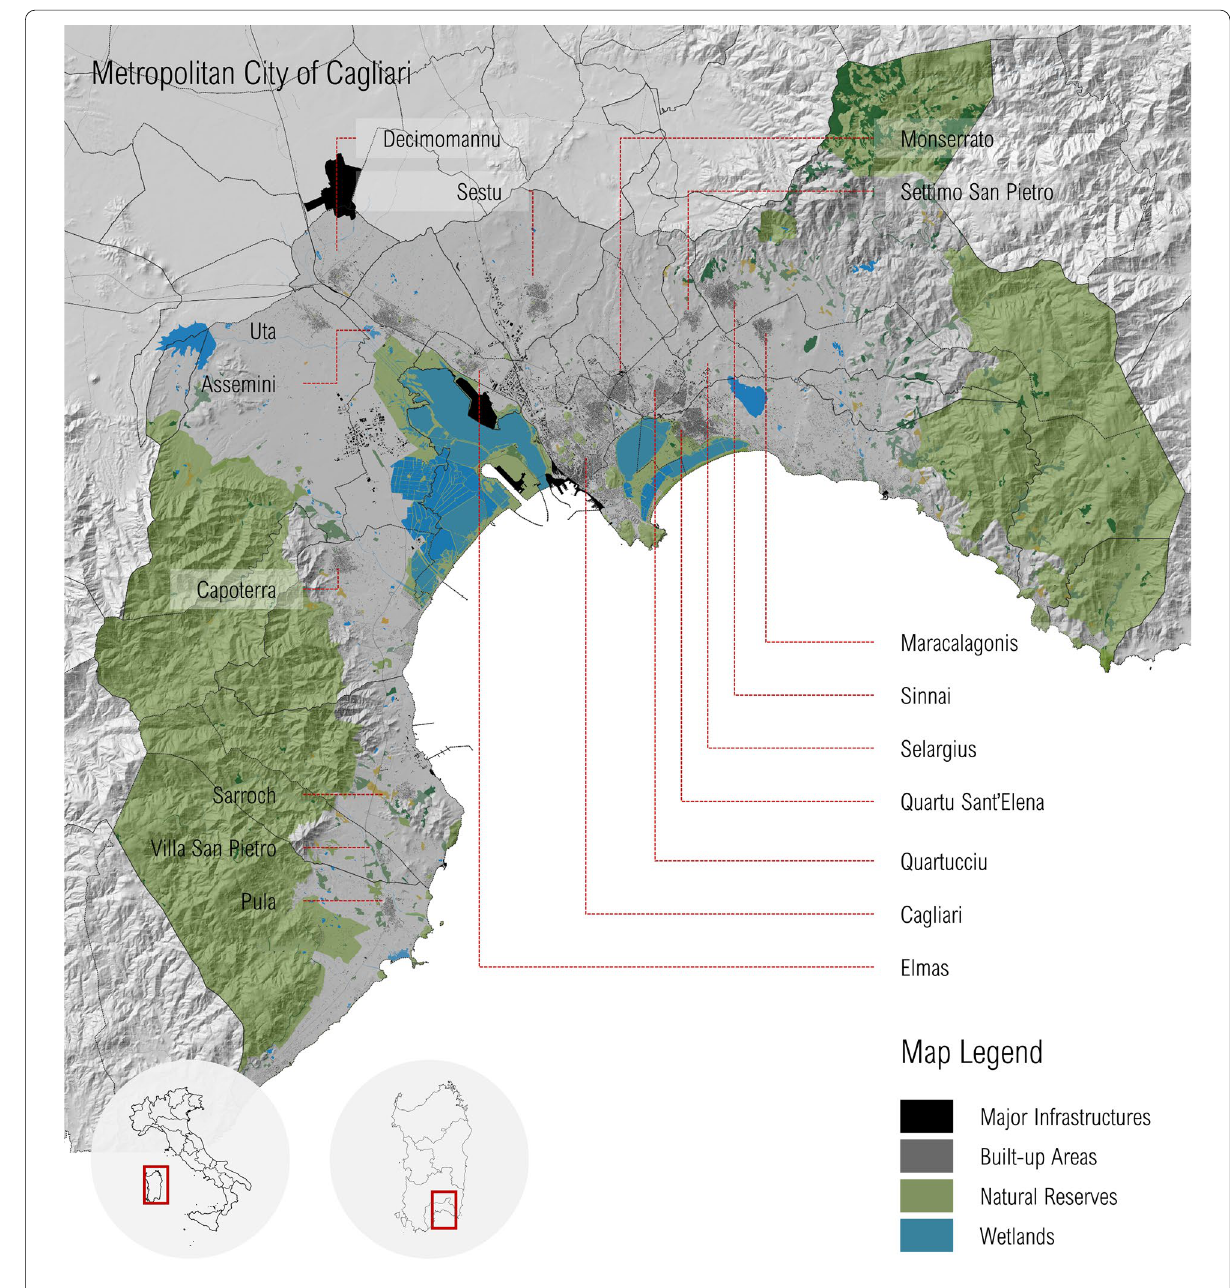
Fig. 3 The Metropolitan City of Cagliari. Ecological infrastructure, built fabric, administrative division, primary